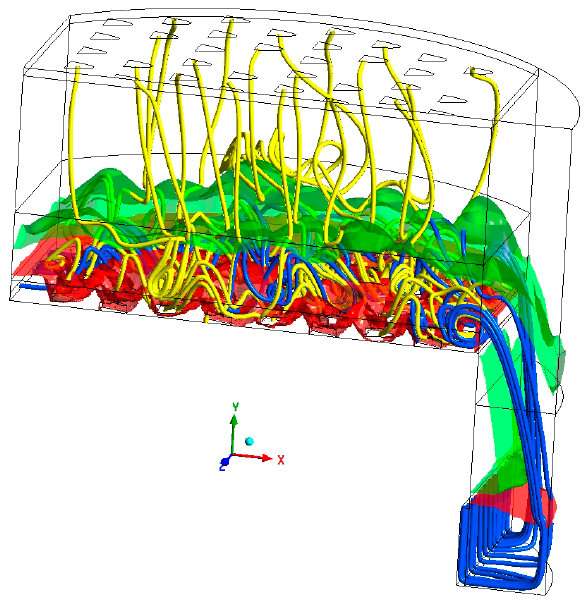
Figure 23. Gas–liquid streamline distribution and